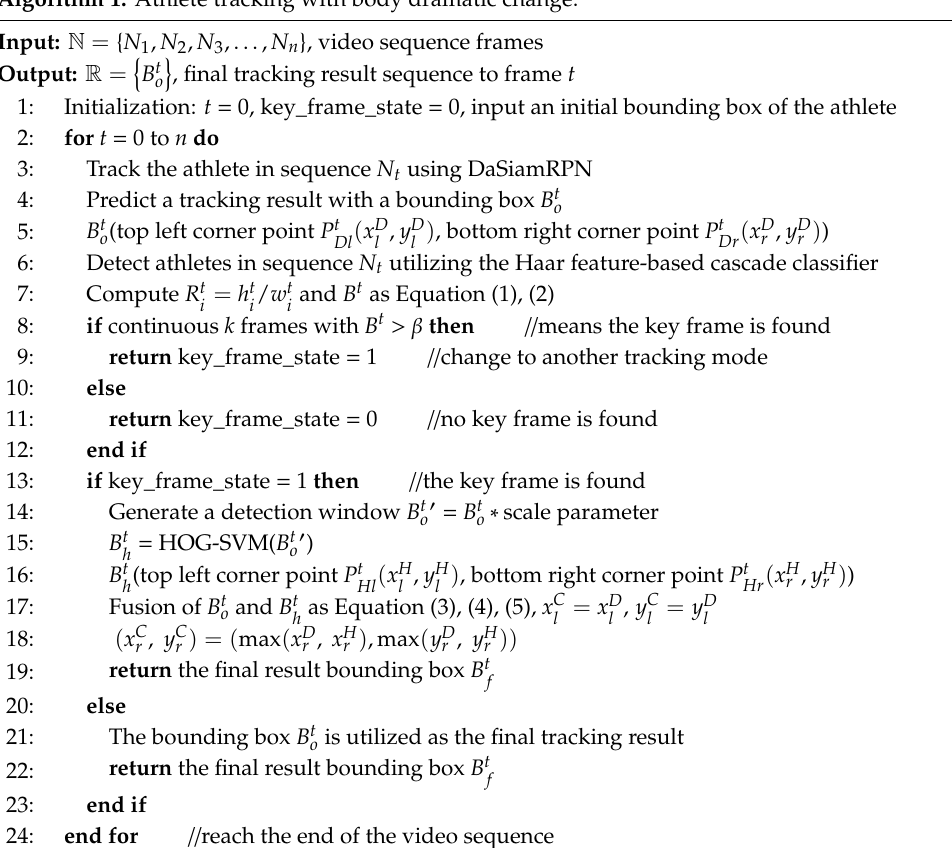
Algorithm 1. Athlete tracking with body dramatic